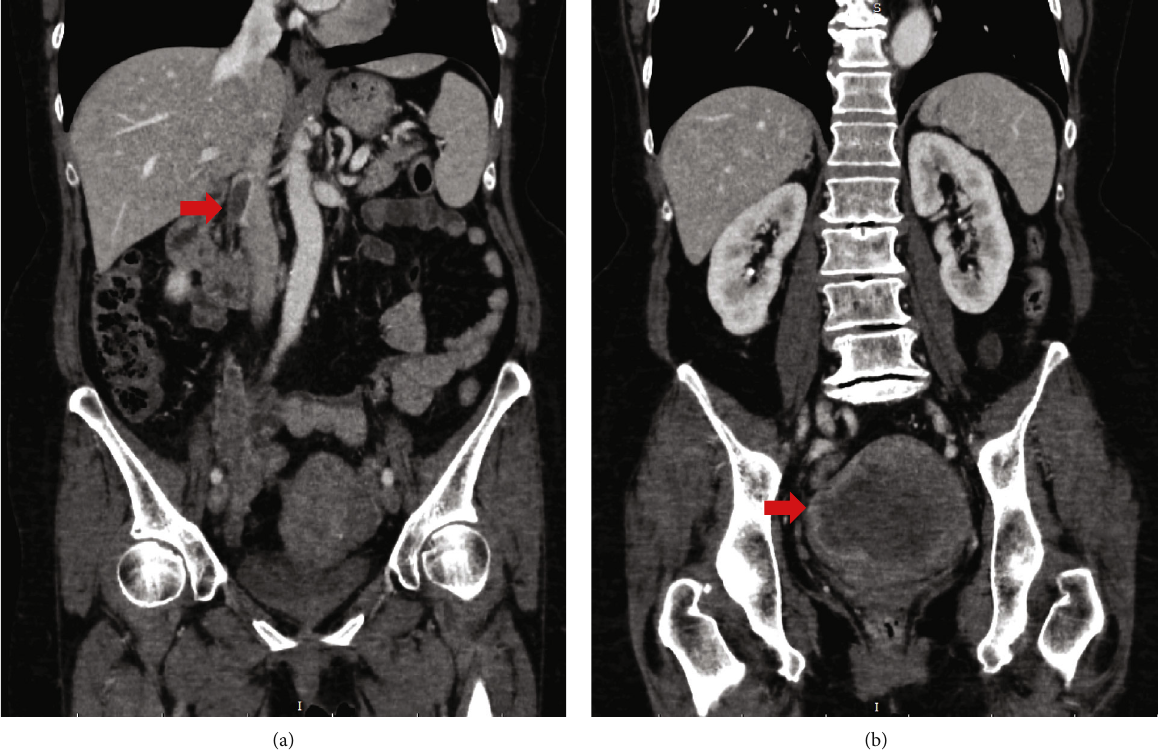
Figure 1: Computed tomography on admission. Intraluminal fi lling defect from the right ovarian vein to the inferior vena cava (arrow) (a) and a large uterine mass (arrow)